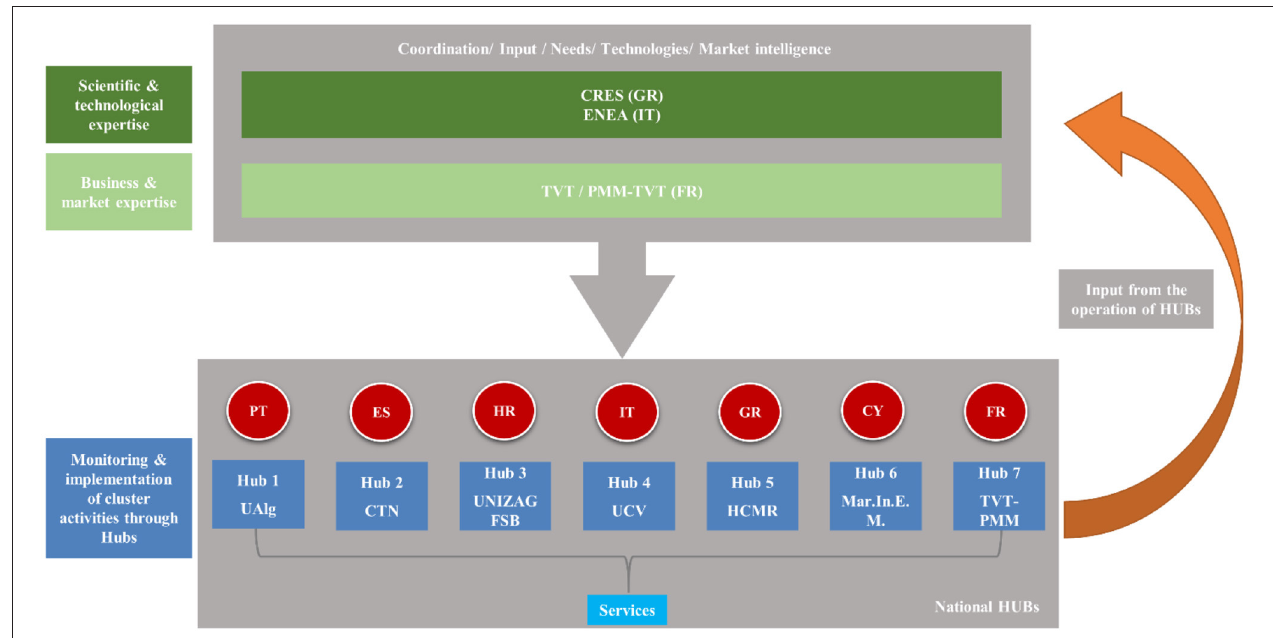
FIGURE 5 | Roles of the PELAGOS